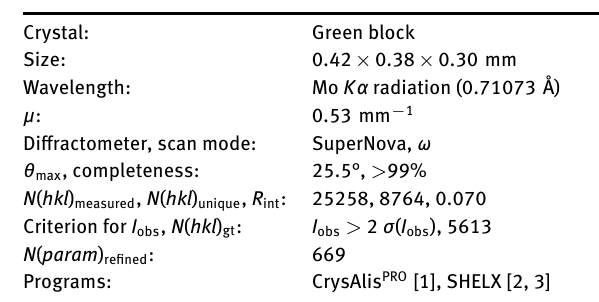
Table 1: Data collection and handling.